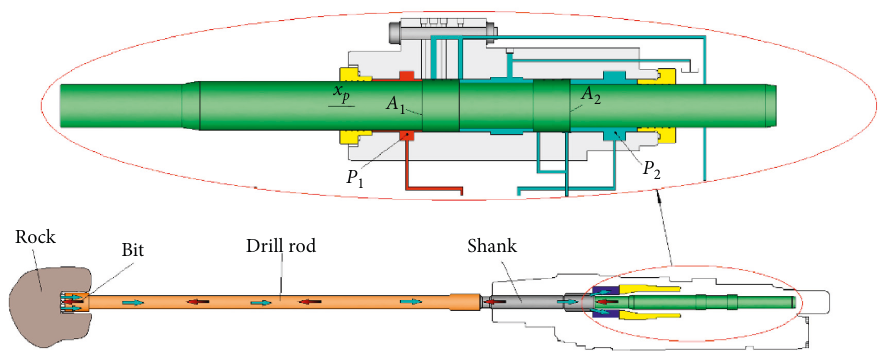
Figure 7: The action force of oil pressure on the impact piston during rock